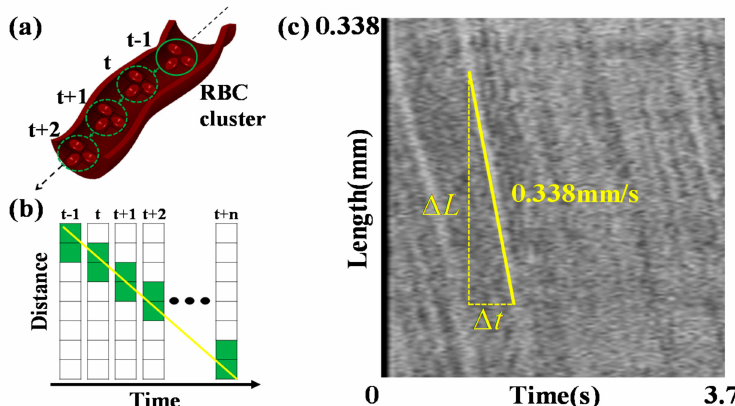
Figure 5. ( a ) The RBC cluster shifts over time in the vessel centerline. ( b ) Pixel intensity of the vessel centerline changes due to the RBC cluster shift. ( c ) Spatial–temporal analysis (STA) image generated by the pixel intensity from the vessel centerline as stacking at each column. The x and y axes indicate the frame time and vessel length, respectively. The yellow line shown in the STA image displays the slope, indicating the blood flow